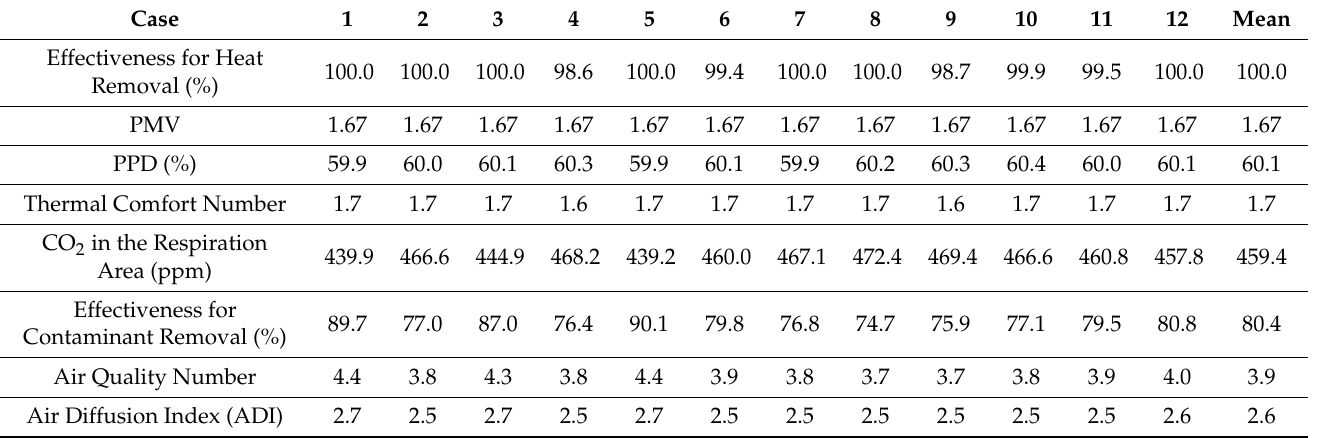
Table 6. ADI obtained for Case I (0.0778 m 3 /s) at 16 h.